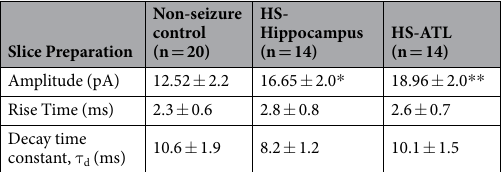
Table 2. Kinetics of Spontaneous EPSCs. Characteristics of spontaneous EPSCs recorded from pyramidal neurons in resected samples from non-seizure control and the hippocampal and ATL samples from HS patients. The data are presented as the mean ± S.E.M. * p = 0.04; ** p = 0.009 compared to non-seizure control according to one-way ANOVA followed by Tukey post hoc